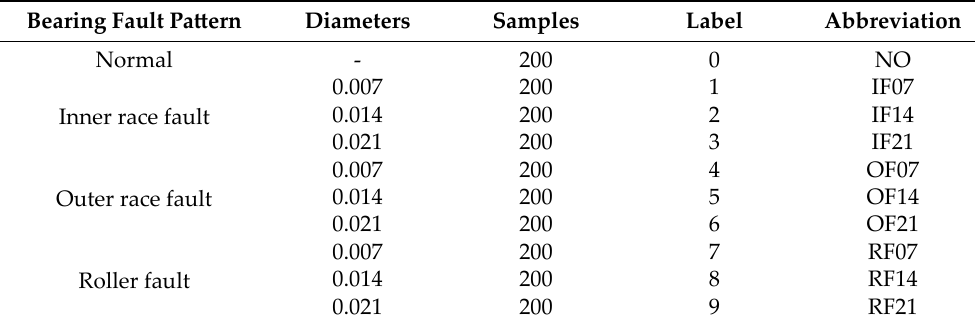
Table 2. Sample configuration information table in each